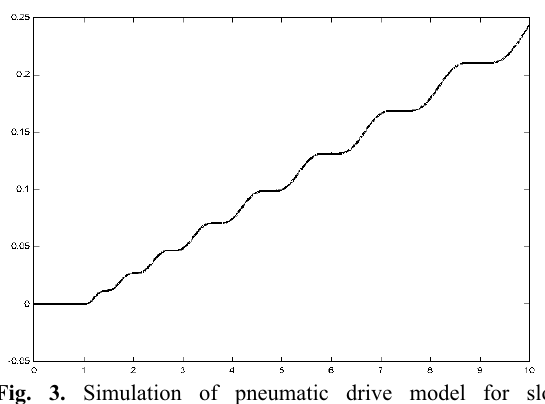
Fig. 3. Simulation of pneumatic drive model for slow movement with combined Stribeck and Coulomb friction.